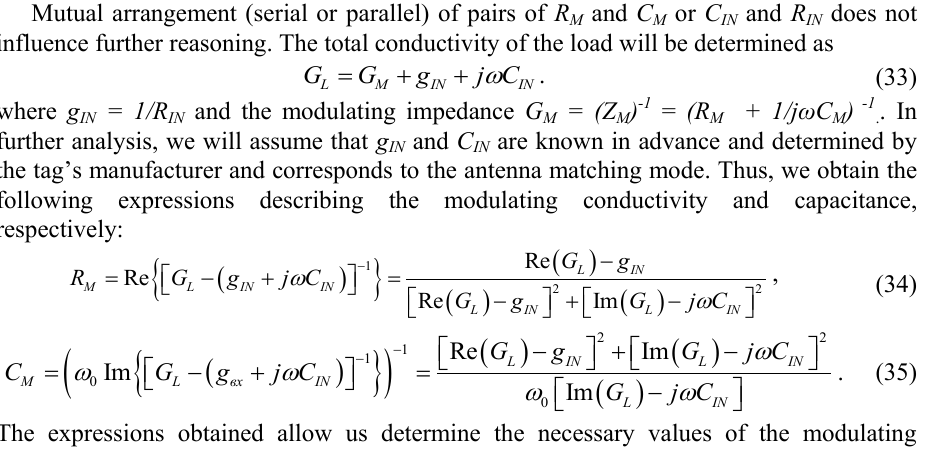
Fig. 2. The equivalent circuit of the tag